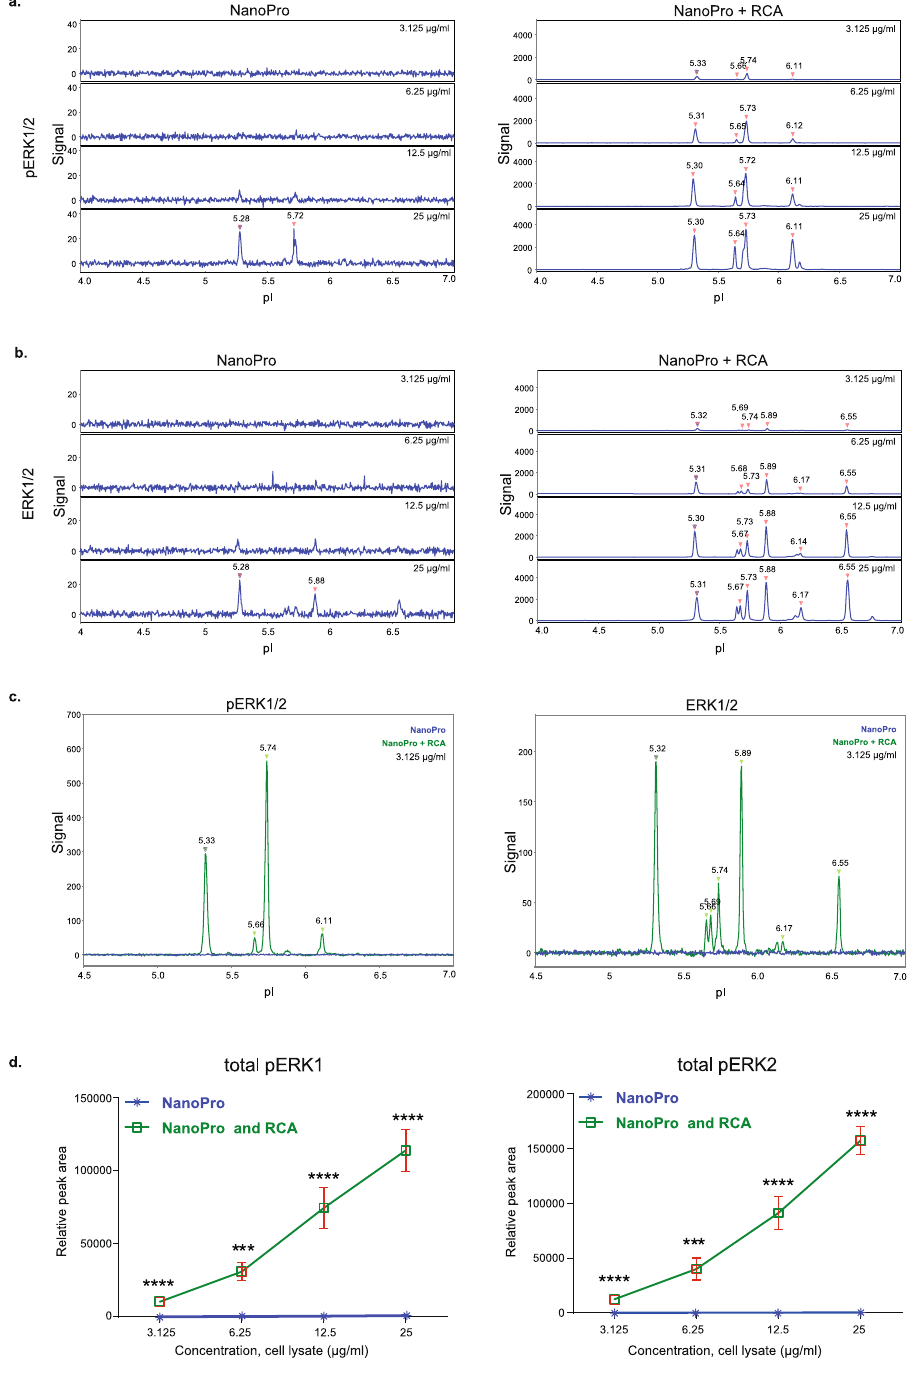
Figure 2. Sensitive detection of phosphorylated and total ERK1/2 protein. ( a ) Electropherogram of phospho- ERK1/2 (pERK1/2) from serially diluted HUVEC lysate (25 µ g/ml to 3.125 µ g/ml), using the standard NanoPro assay (left) and NanoPro + RCA (right). ( b ) Detection of ERK1/2 as in ( a ). ( c ) Detailed overlay graph of pERK1/2 (left) and ERK1/2 (right) analyzed by standard NanoPro assay (blue) and NanoPro + RCA (green) in 3.125 µ g/ml cell lysate. ( d ) Areas extracted from pI peaks corresponding to total pERK1 and pERK2 (as in c ), from 25 µ g/ml to 3.12 µ g/ml serially diluted cell lysates. Quantification was done from three biological replicates (n = 3) with three technical replicates for each sample. Statistical significances were calculated using Student’s unpaired t-tests. p < 0.05 was considered statistically significant. *** p < 0.001 and **** p < 0.0001. Error bars in the graph represent mean ±